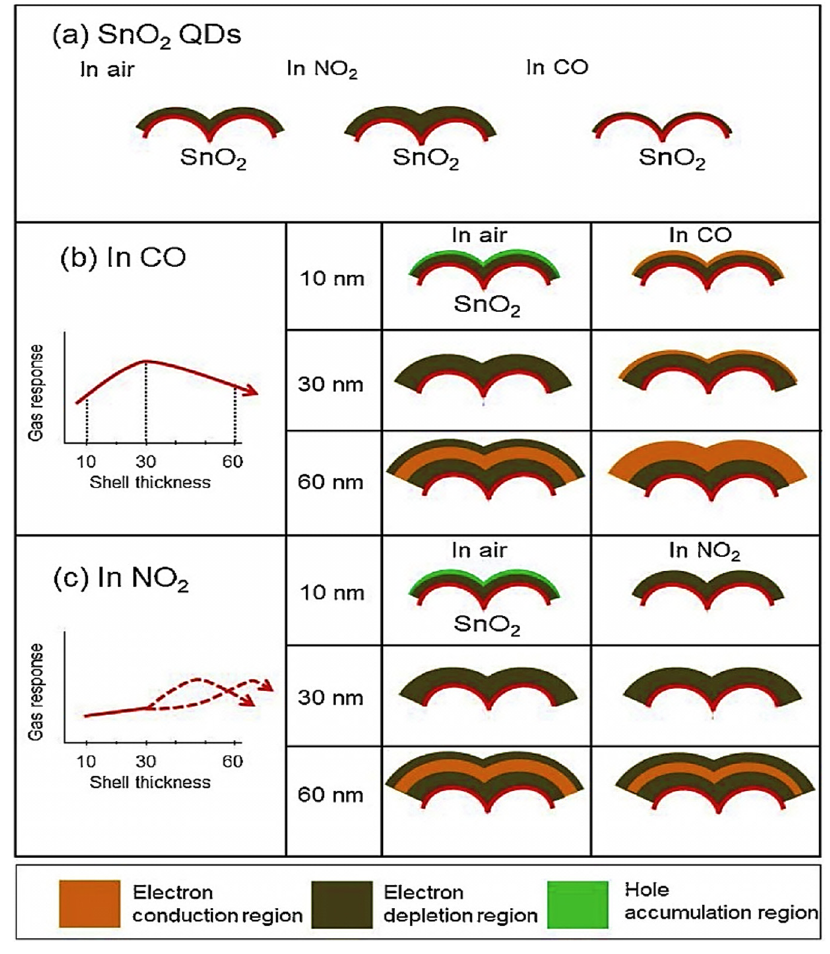
Figure 17. Schematic of the NO 2 and CO-sensing mechanism for ( a ) pristine SnO 2 QDs and ( b , c ) TiO 2 -layer-modified SnO 2 QDs with different layer thicknesses. Reproduced from [108] with the permission of Elsevier.